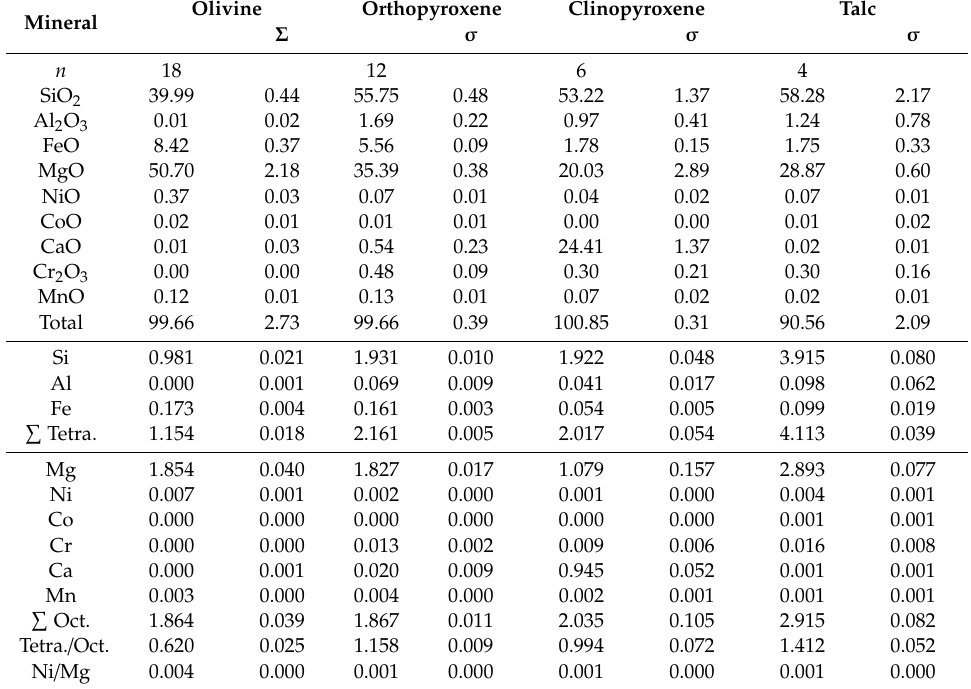
Table 1. Average chemical compositions (wt%) and structural formula (apfu) of olivine, orthopyroxene, clinopyroxene, and talc in the peridotite